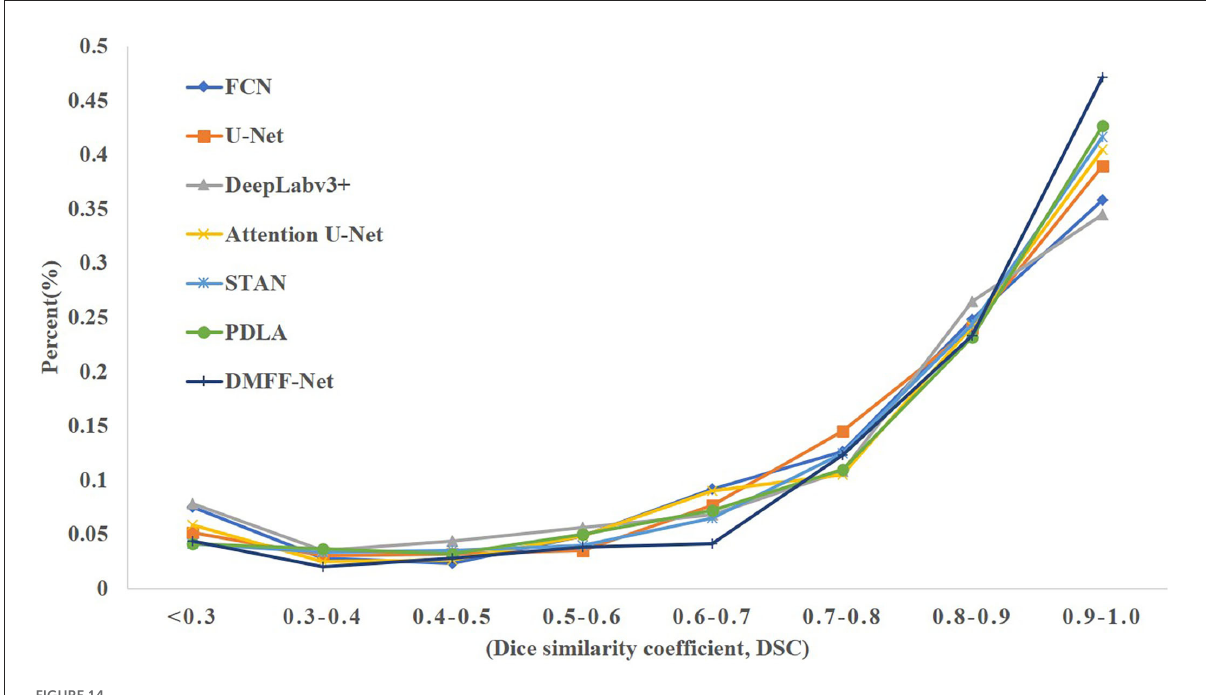
FIGURE14 The DSC distribution on the skin lesion test set for each